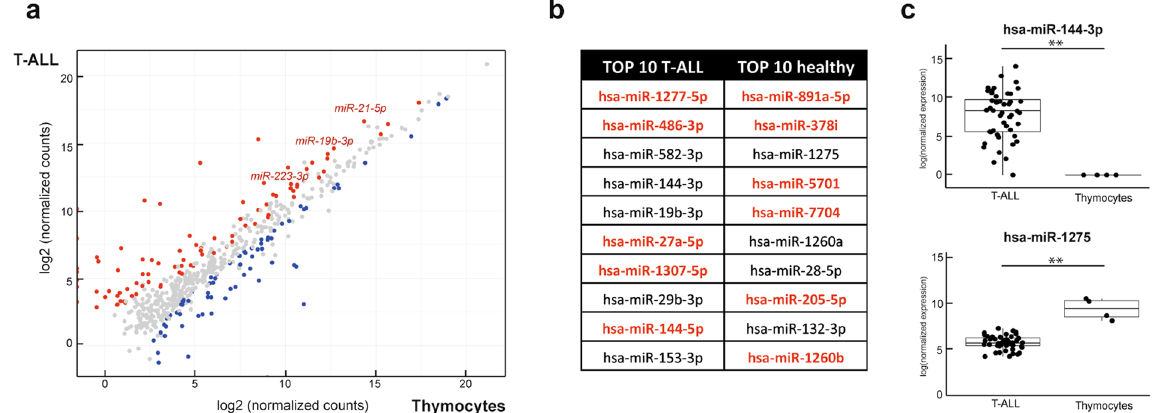
Figure 5. Novel oncogenic miRNAs are detected by small RNA-sequencing. ( a ) Diagonal plot showing the expression of the miRNAs in T-ALL compared to healthy donor thymocytes. Red dots represent miRNAs that are significantly higher expressed in the T-ALL patient samples, blue dots are the miRNAs significantly higher expressed in thymocyte subsets. ( b ) Top 10 most significantly upregulated miRNAs in the T-ALL patients and in the healthy donor samples. MiRNAs denoted in red were not detected by a previously used RT-qPCR platform. ( c ) Dot plots of two representative miRNAs from the table. ** Significant difference with an adjusted p-value <